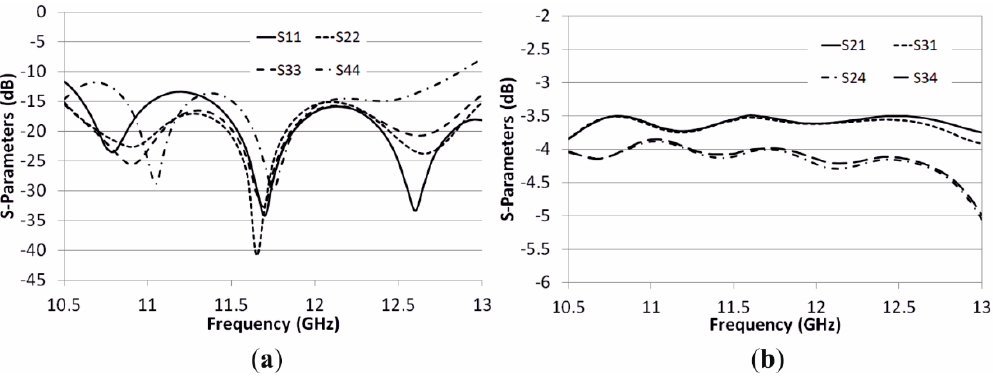
Figure 12. Experimental response of the Magic Tee prototype shown in Figure 11. ( a ) Reflection coefficients; ( b ) Transmission coefficients.